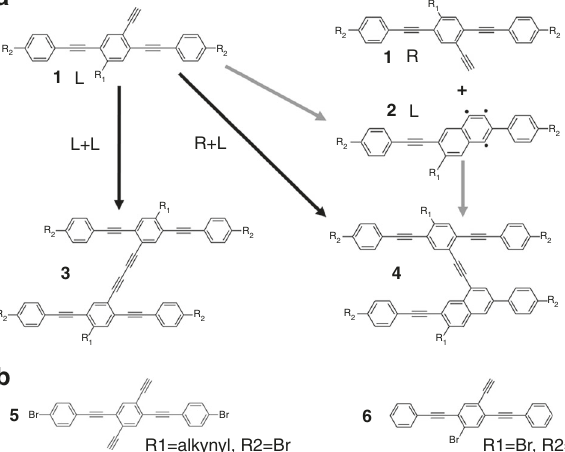
Fig. 1 The reaction scheme of alkyne molecules. a The potential reaction pathways of chiral terminal alkyne 1 , forming 3 from homochiral intermolecular reaction and 4 from heterochiral intermolecular reaction. b The precursor molecules used in this